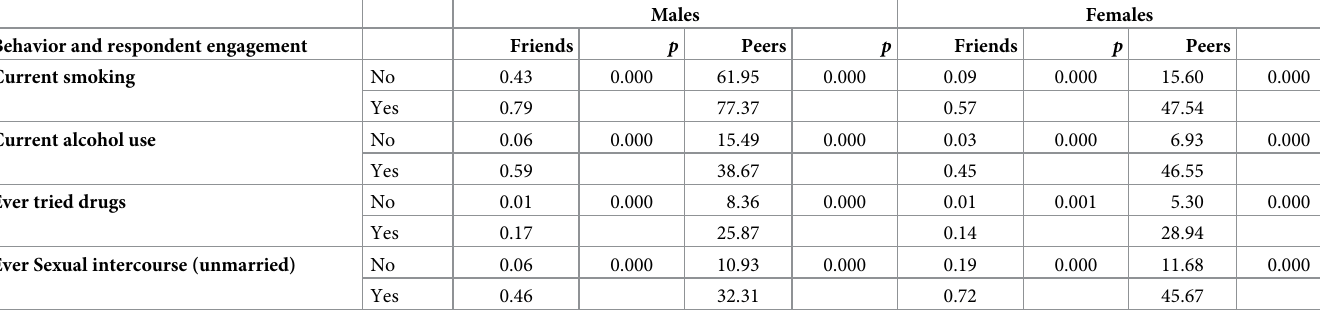
Table 3. Means of friends’ and peers’ engagement in risk behaviors by respondent’s engagement in the behavior